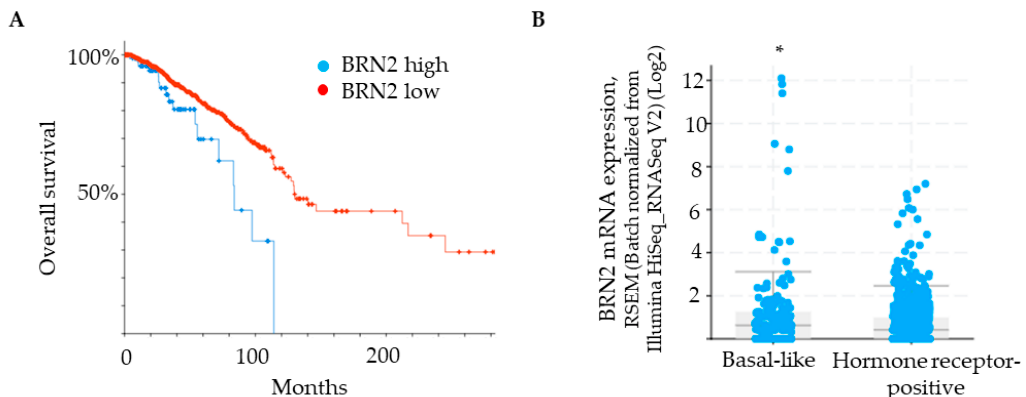
Figure 4. BRN2 expression positively correlates with poor patient survival and is higher in patients with a basal-like subtype of breast cancer. ( A ) Kaplan–Meier plot showing that overall survival of breast cancer patients is correlated with BRN2 expression (0.1 FPKM cut-off; p -value, 3.651 × 10 − 3 . ( B ) BRN2 gene expression in breast cancer tumors grouped as basal-like or hormone receptor-positive ( p -value, 1.644 × 10 − 3 ). * p < 0.05.